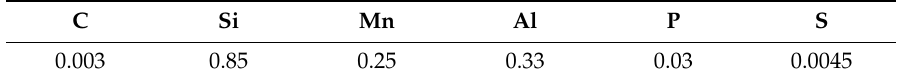
Table 4. Chemical composition of non-oriented silicon steel (wt.%).